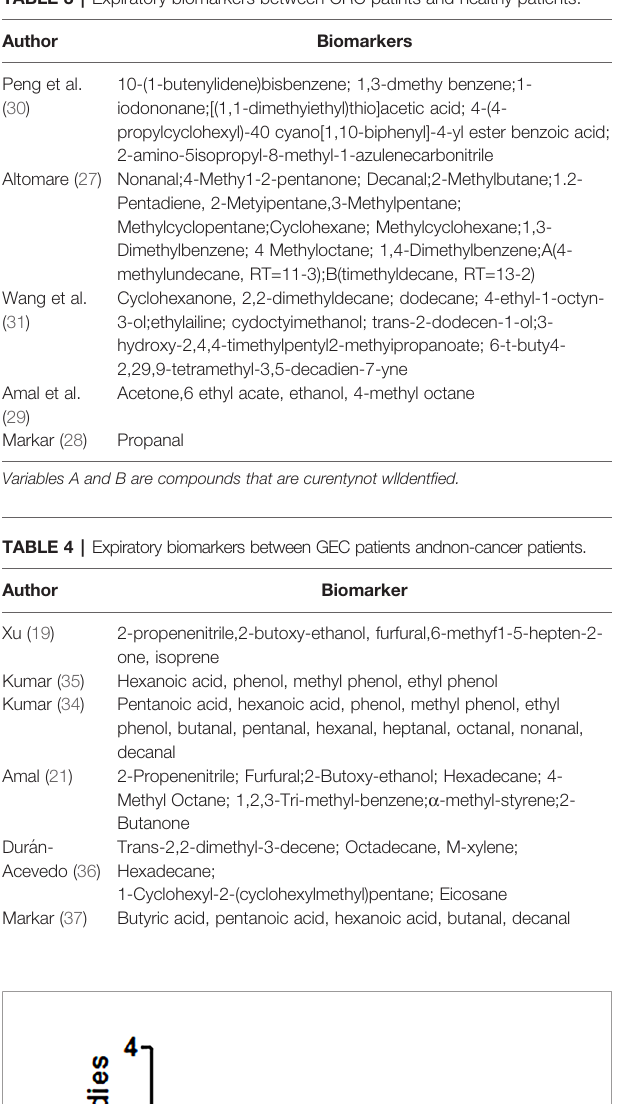
TABLE 3 | Expiratory biomarkers between CRC patints and healthy